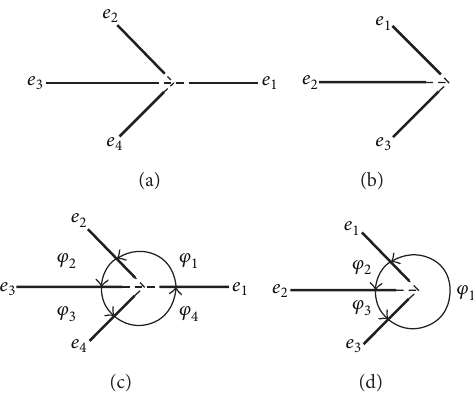
Figure 7: Elements for